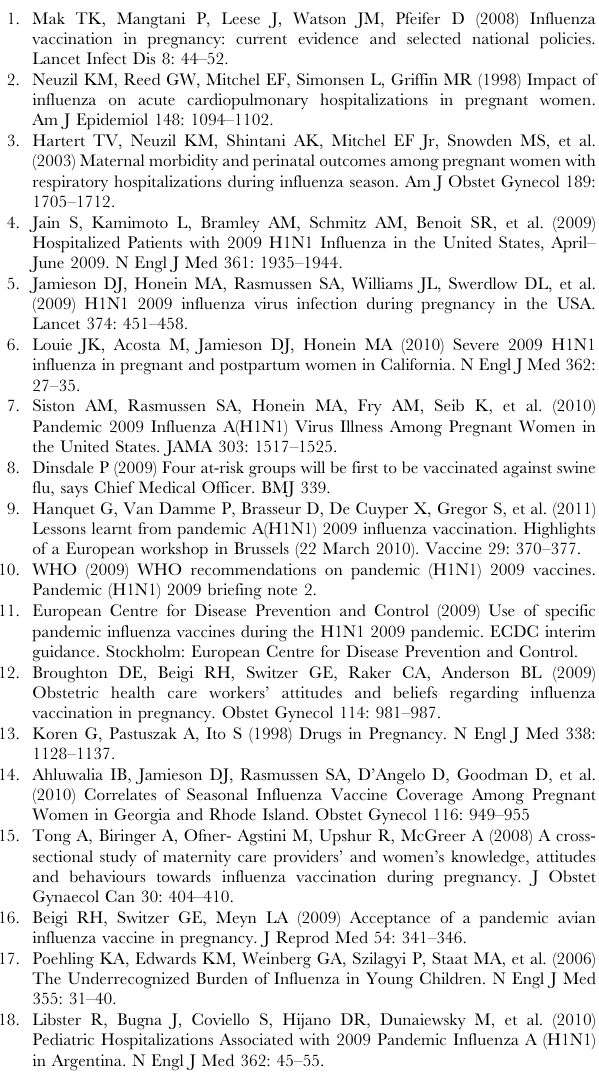
Table S1 Multivariate logistic regression model for prediction of immune titre HI $ 1:40 and MN $ 1:60